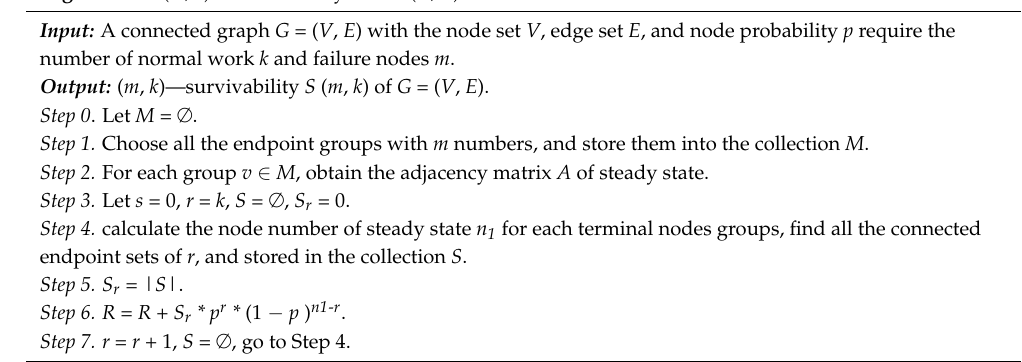
Algorithm 1: ( m , k )—survivability in G = ( V , E ) Input: A connected graph G = ( V , E ) with the node set V , edge set E , and node probability p require the number of normal work k and failure nodes m .